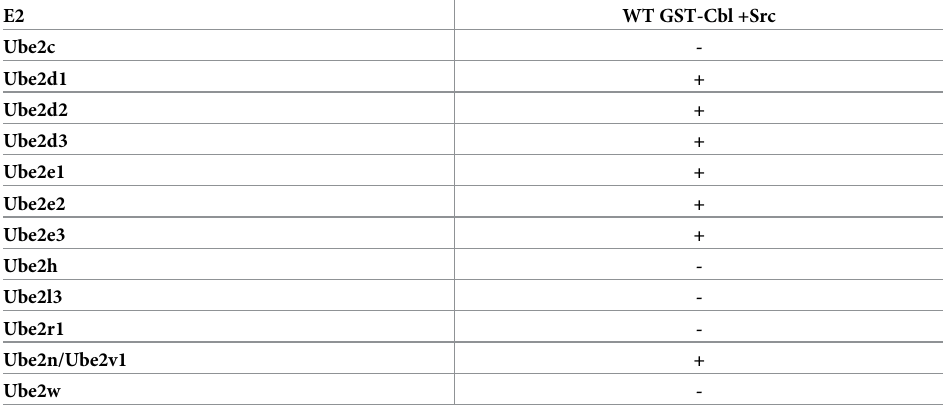
E2 Ube2c - Ube2d1 + Ube2d2 + Ube2d3 + Ube2e1 + Ube2e2 + Ube2e3 + Ube2h - Ube2l3 - Ube2r1 - Ube2n/Ube2v1 + Ube2w - All the E2s were tested in an in vitro E3 assay using WT GST-Cbl (aa 2–469) in the presence of active full-length Src. +, E2 supported E3 activity;–, E2 did not support E3